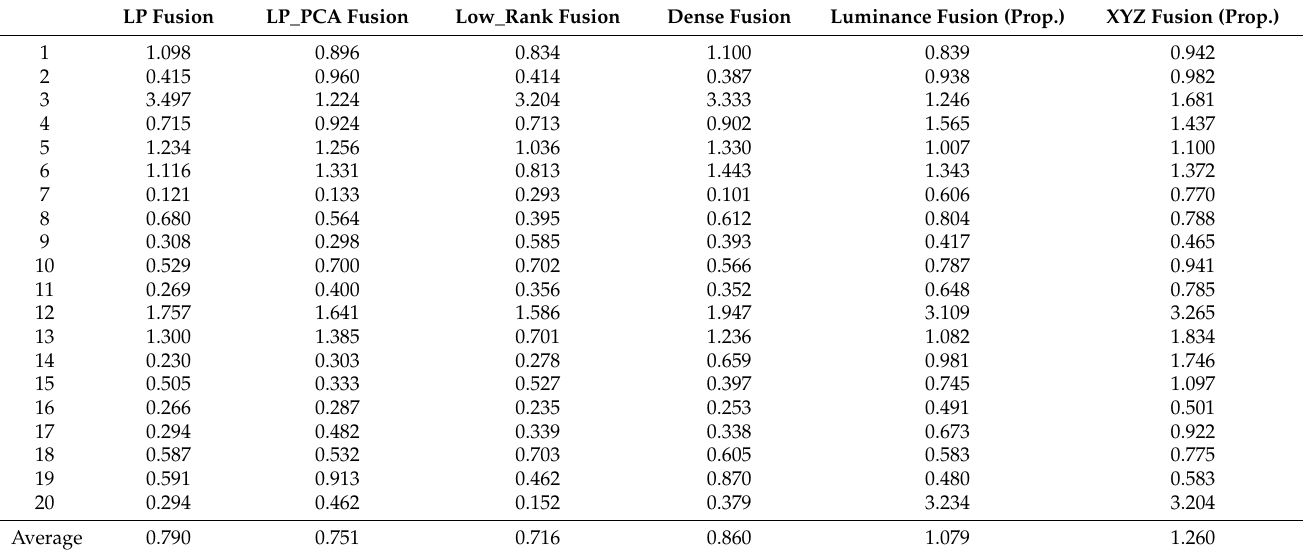
Table 6. Comparison of the Cross-entropy metrics.